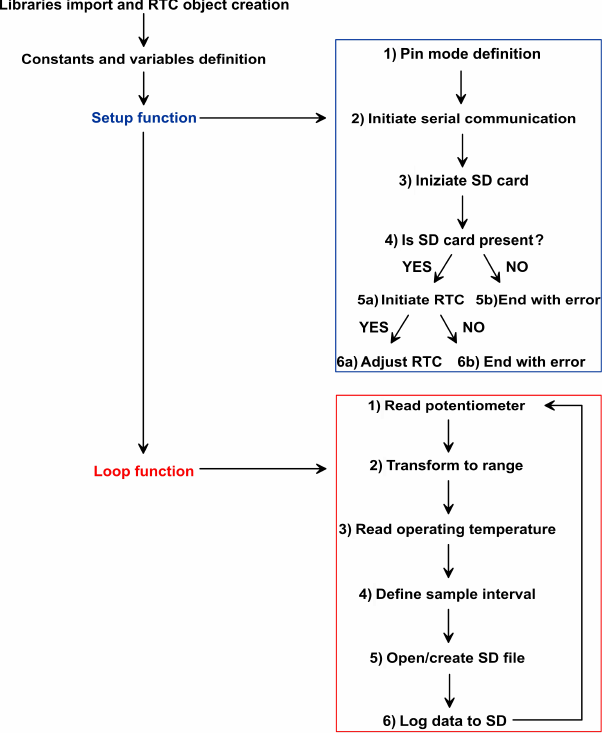
Figure 2. Flow chart showing acquisition and storage